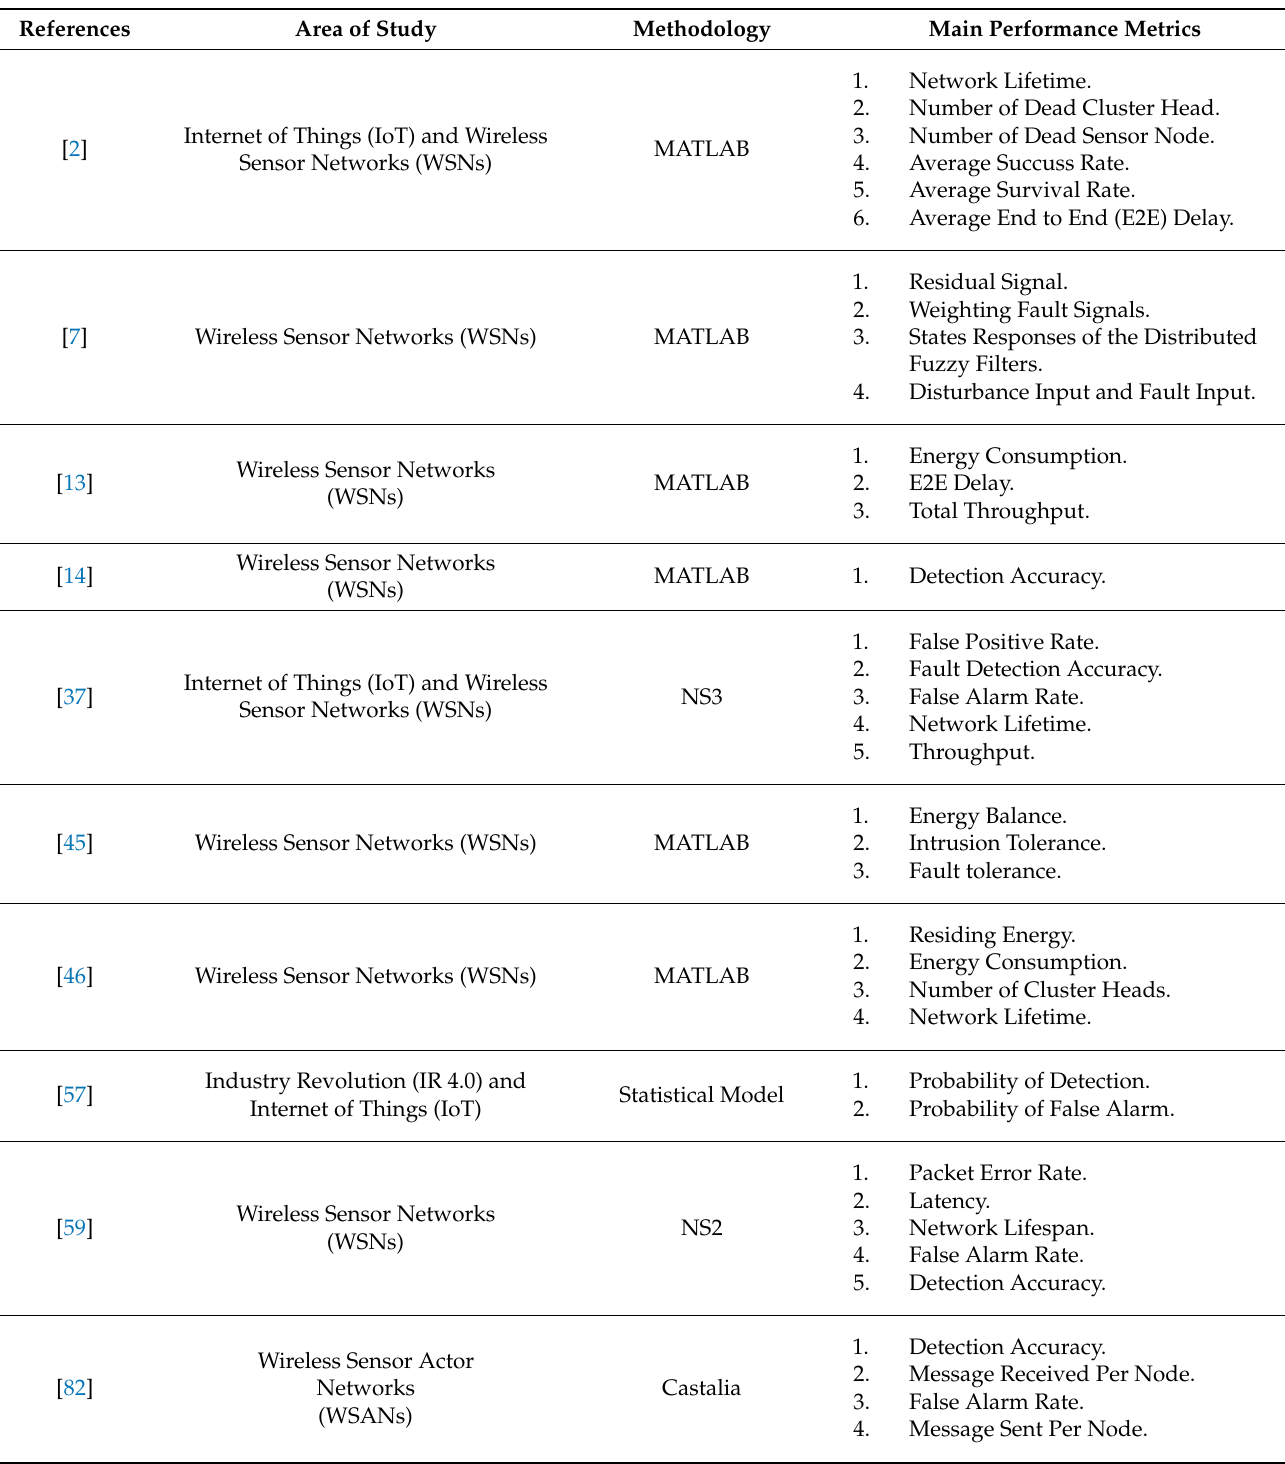
Table 3. Primary Information, Methodology, and Performance